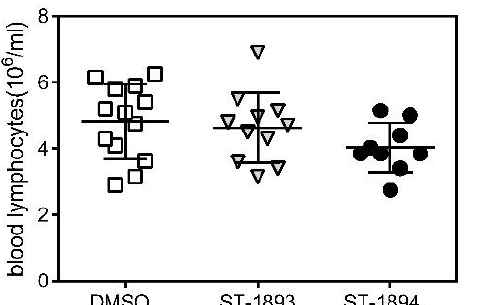
Figure 9. Effect of SK-2 deficiency on the lymphocyte number after ST-1893 and ST-1894 administration in vivo. C57BL/6J SK-2 knockout mice were injected intraperitoneally with 5 mg/kg ST-1893, ST-1894, or DMSO in PBS as a control, and, after 24 h blood, was collected in EDTA-K3- coated microvettes with cardiac puncture under deep terminal isoflurane-induced anesthesia. The number of lymphocytes per mL was assessed as explained in Section 4 and is presented as means ± SD ( n = 13 for DMSO; n = 11 for ST-1893; n = 9 for ST-1894).